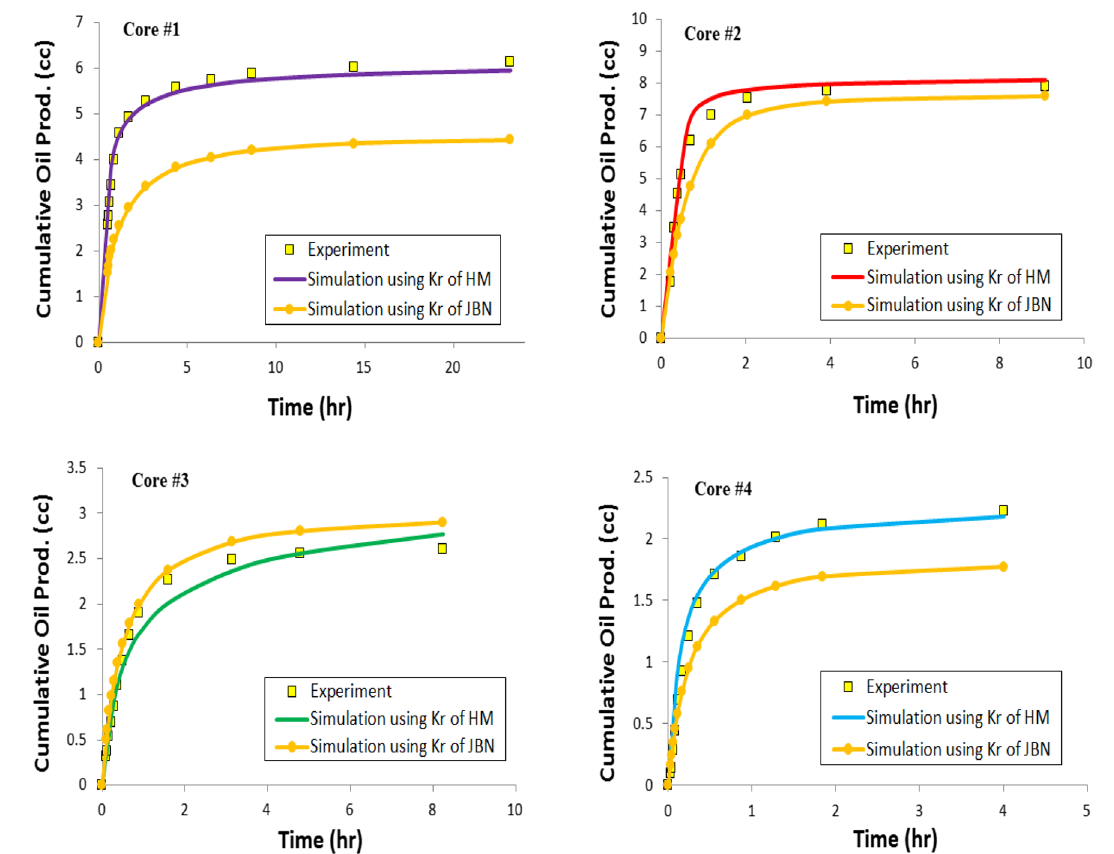
Fig. 4 Experimental results of cumulative oil production compared to the simulation results using k